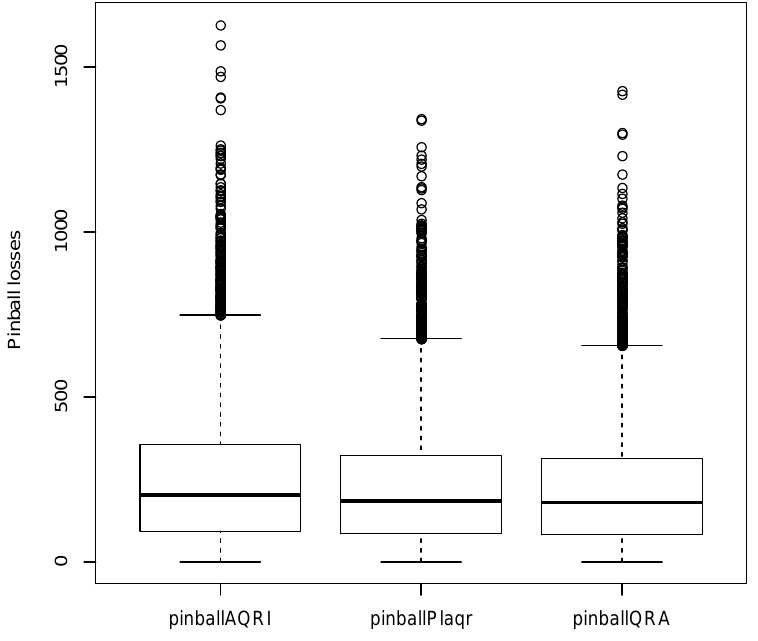
Figure 4. Plot of pinball losses for models M 4 (pinballAQRI), M 5 (pinballPlaqr) and M 6 (pinballQRA) (2 April 2012 to 31 December 2012).